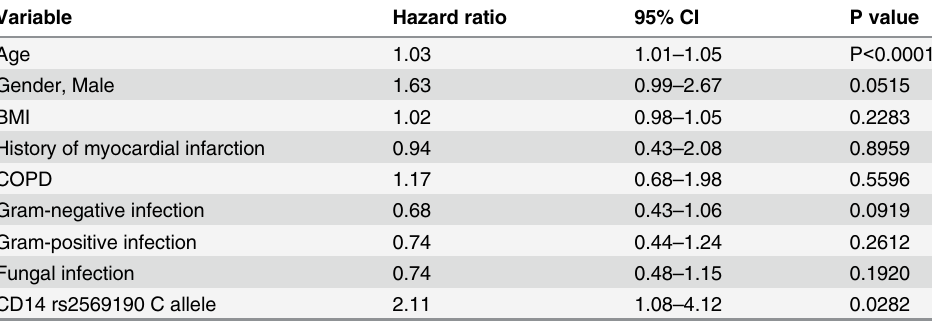
Table 3. Cox regression analysis.